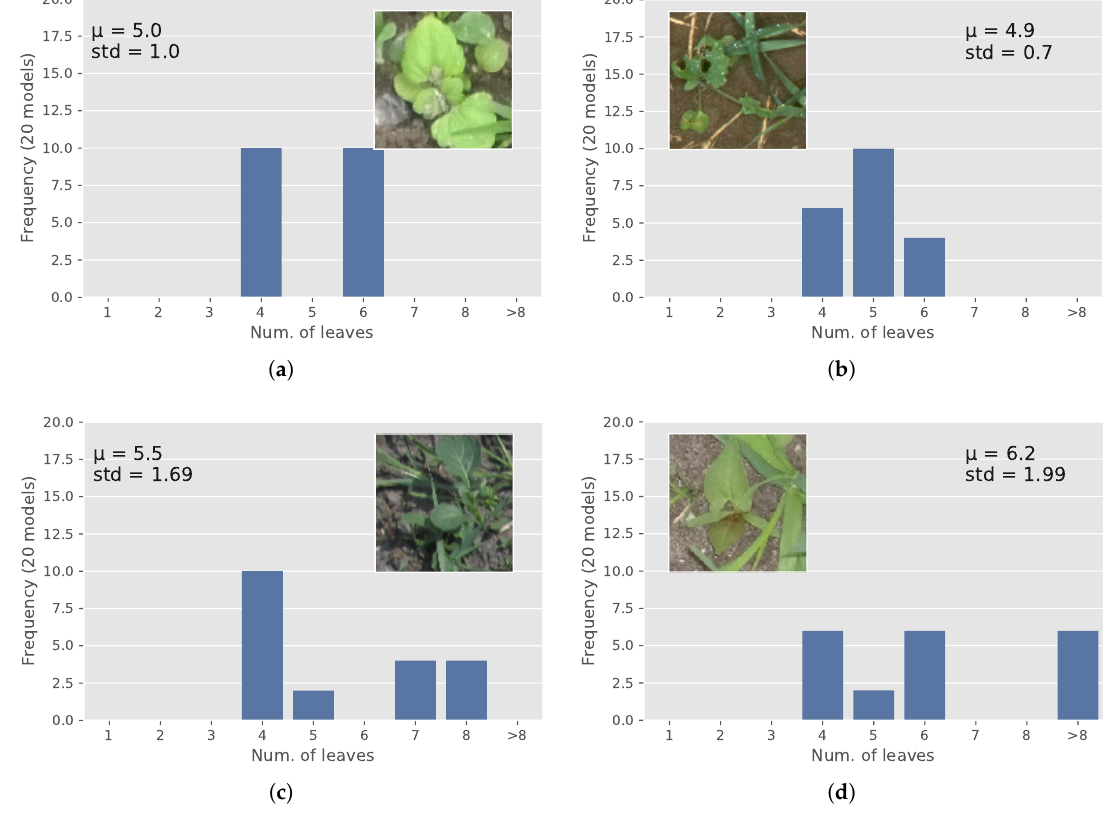
Figure 9. Some hard cases that the models could not classify correctly. Correct labels are: ( a ) four; ( b ) four; ( c ) four; ( d )